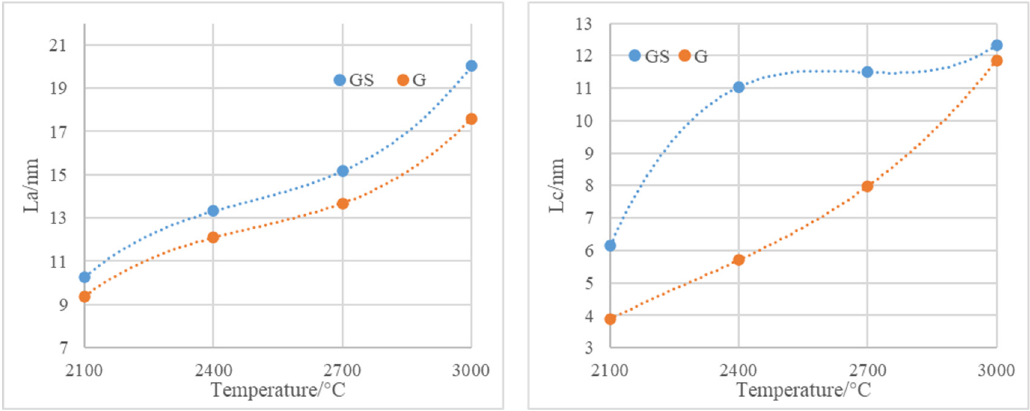
Figure 11. XRD parameter (La and Lc) evolution characteristics with temperature.